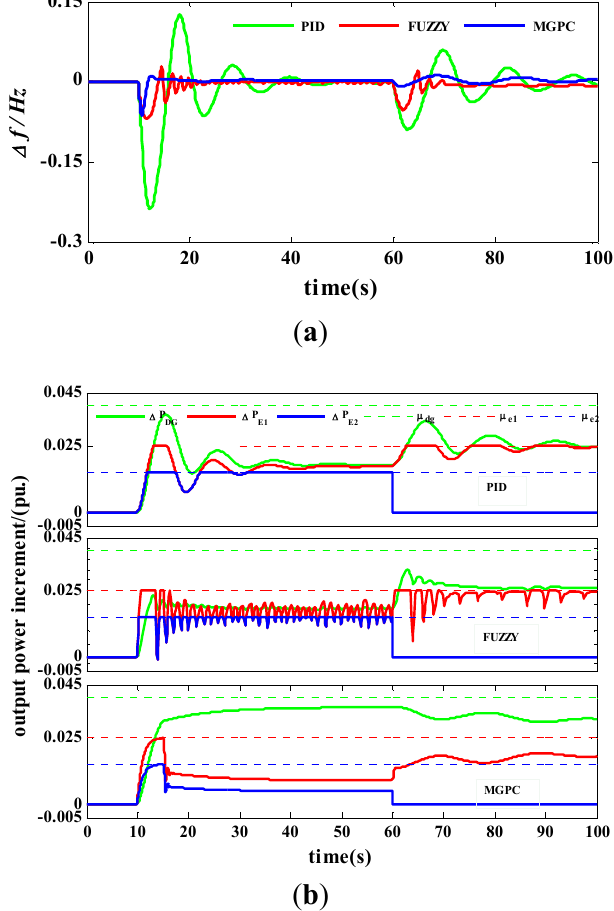
Figure 7. ( a ) The frequency deviation of the micro-grid with constraints using PID control, FUZZY control and MGPC control; ( b ) The output power increment of DG, EV1 and EV2 with constraints using PID control, FUZZY control and MGPC